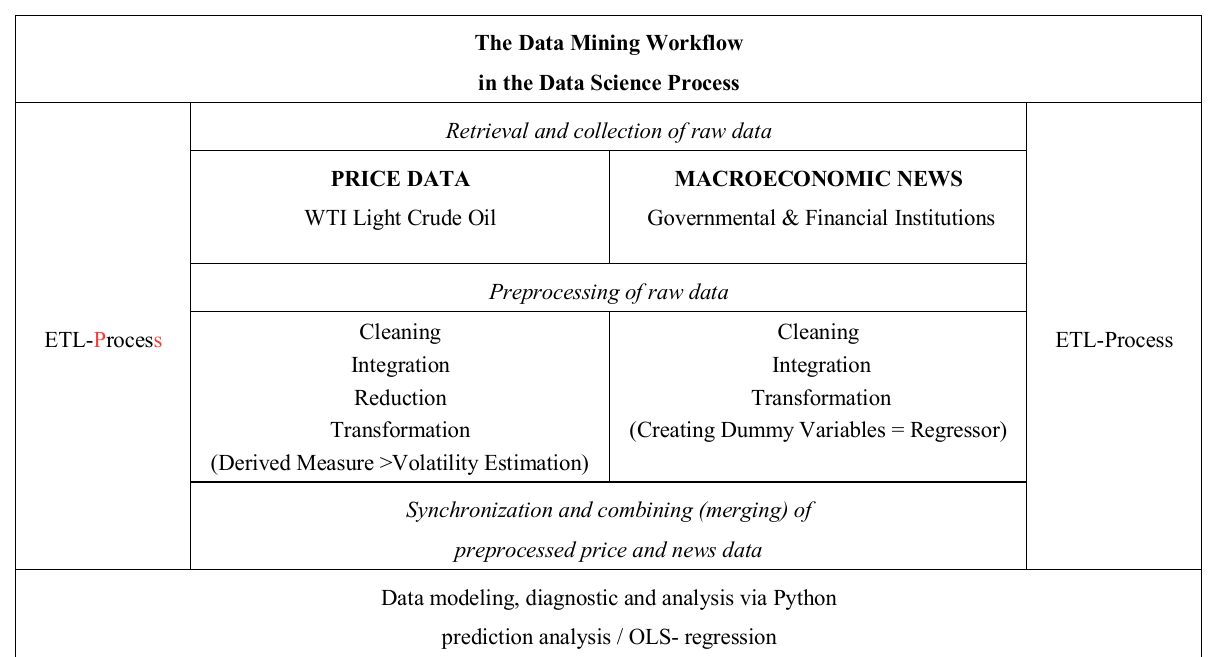
Table 1: Overview of the implemented data science process using data mining techniques.